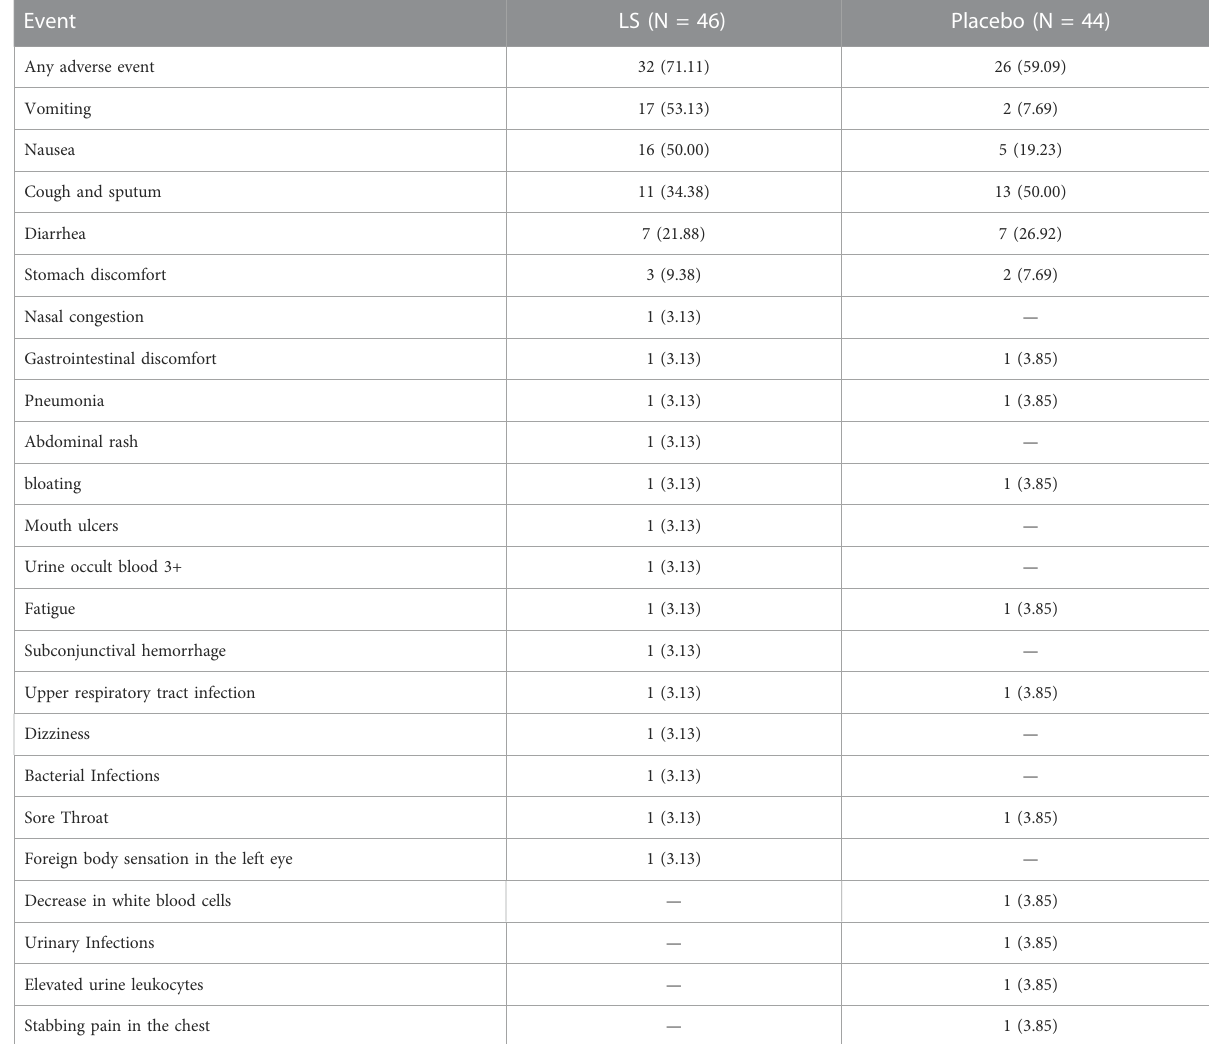
TABLE 7 Adverse events in LS and Placebo group during